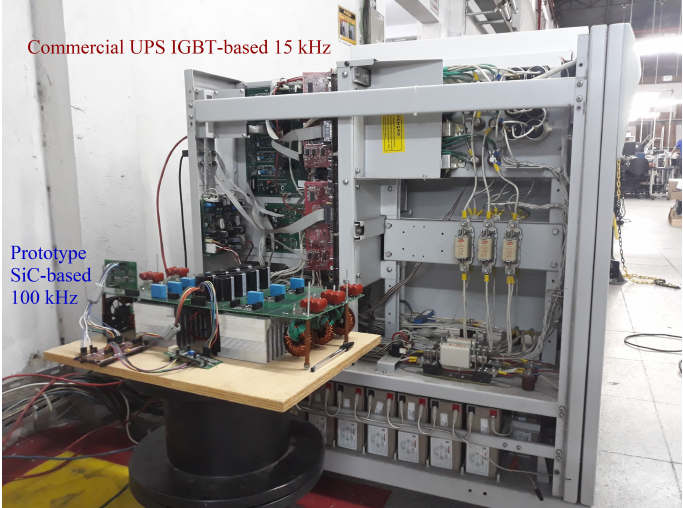
Figure 10. Size comparison between the developed SiC-based prototype and a commercial IGBT-based Uninterruptible Power Supply (UPS) with the same